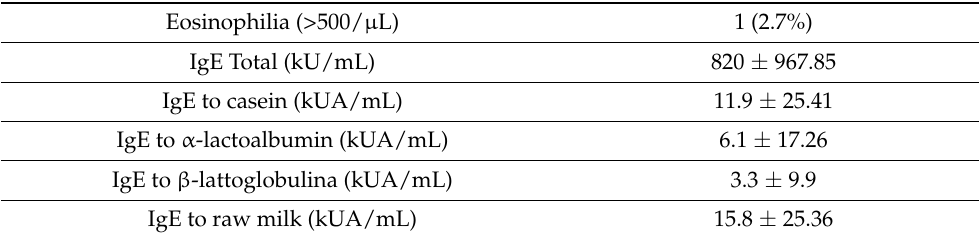
Table 2. Laboratory data at the last follow-up during OIT.